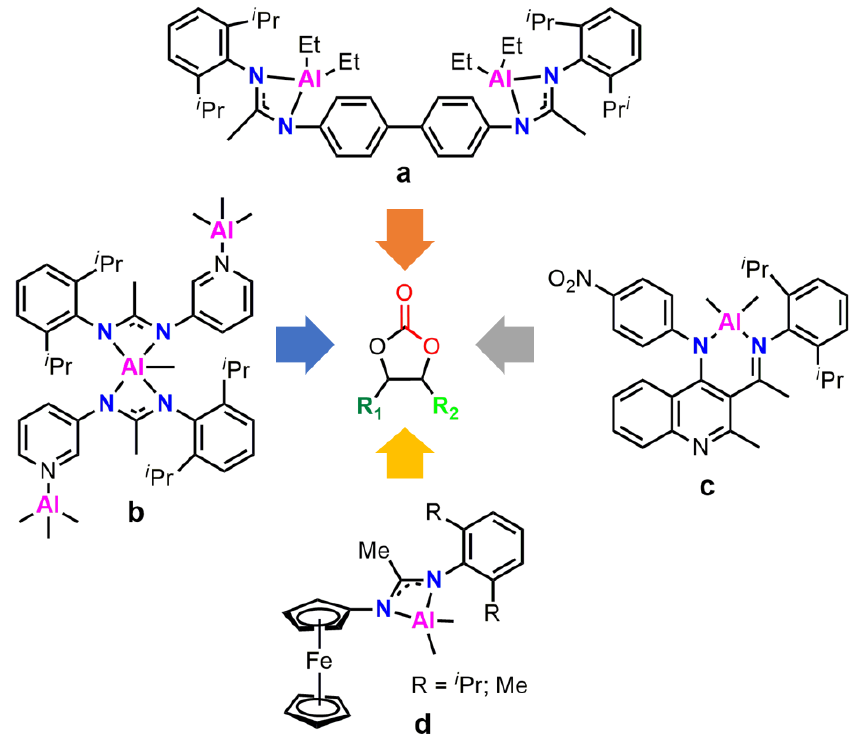
Figure 2. Aluminum complexes used for the synthesis of cyclic carbonates.